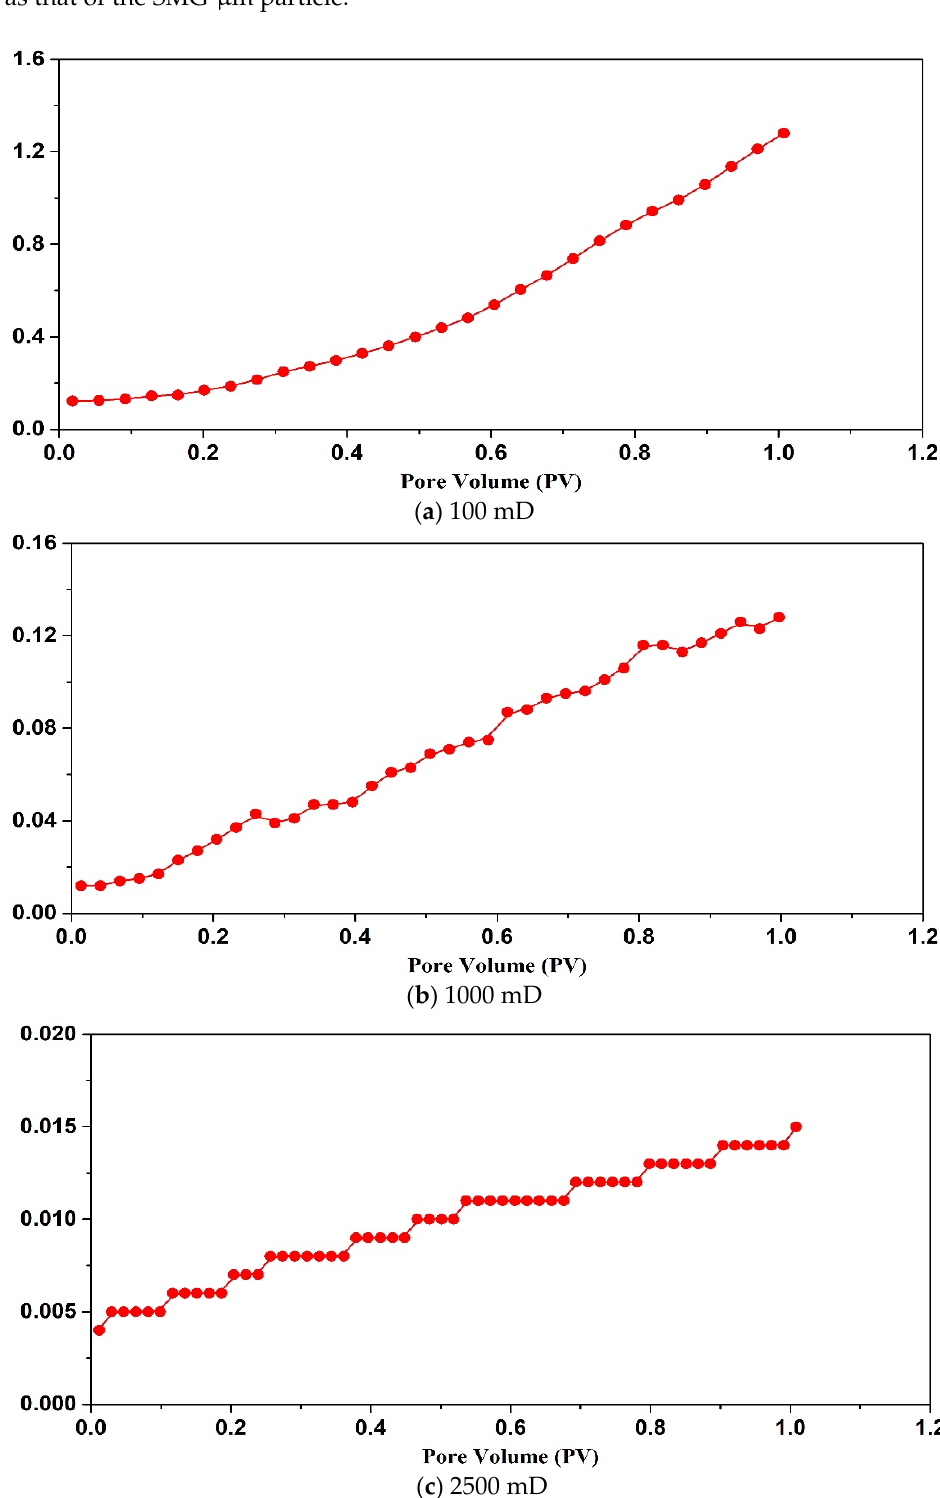
Figure 7. The experiment results of matching between SMG-mm − and reservoir.